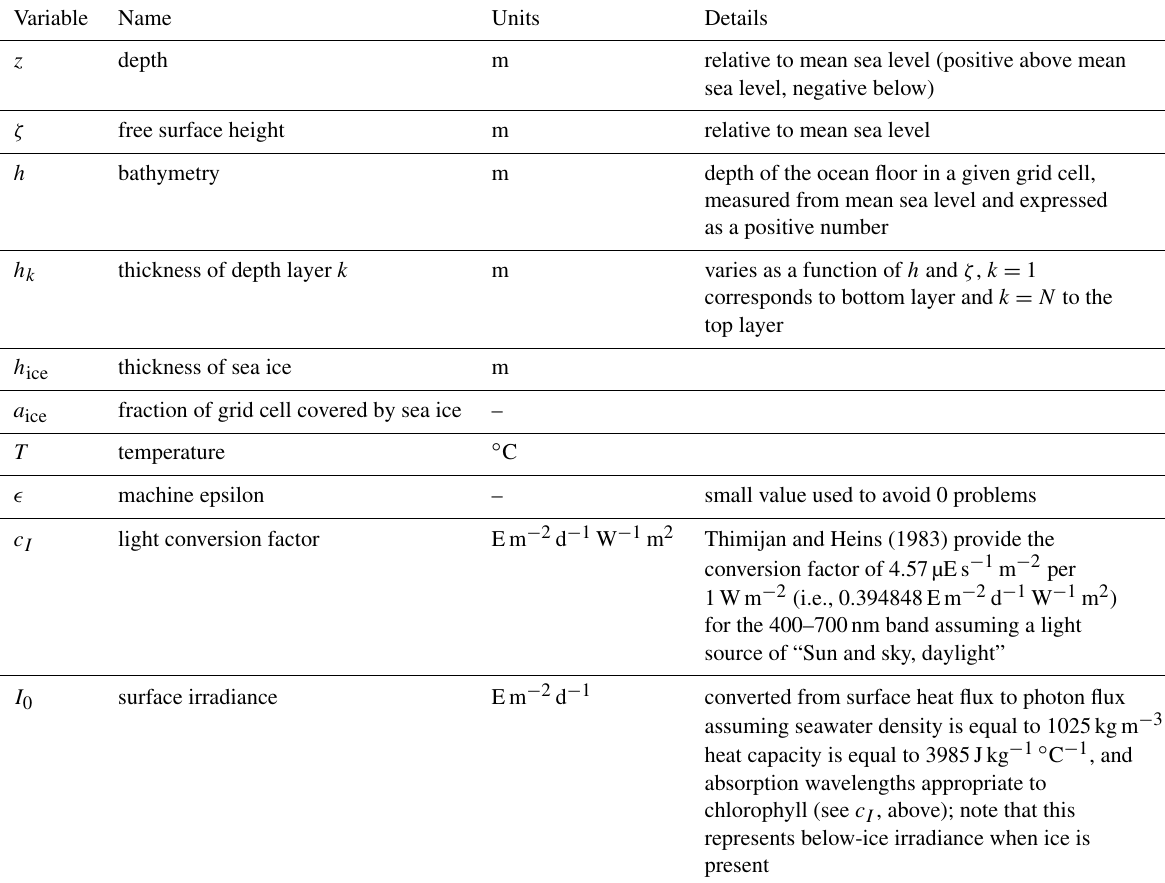
Table A2. Notation and description for variables derived from the physical model.